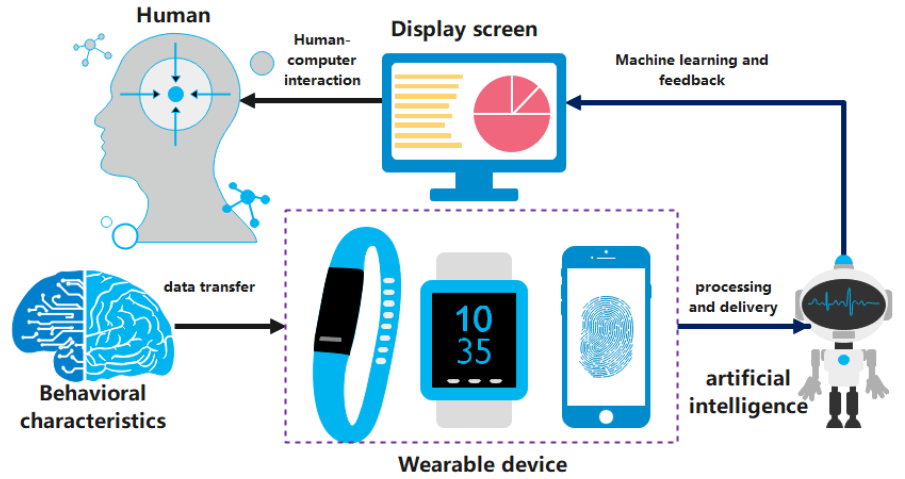
Figure 2. Human–computer interaction model